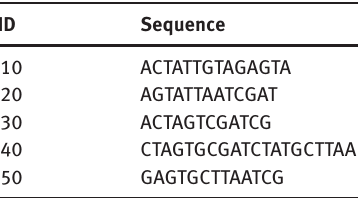
Table 4: Sample DNA Sequence